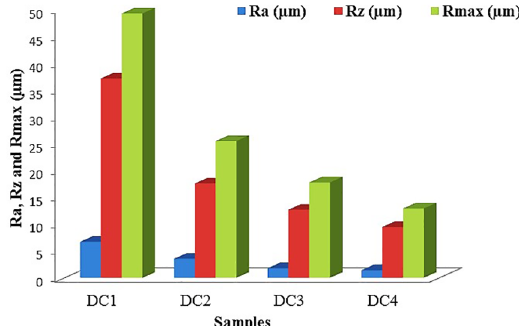
, the maximum Figure 5. Plot of the arithmetic mean deviation R a height R and the highest peak R of the surface roughness. z max the roughness level is high compared to the top of the peak, then the highest peak of R or the maximum height of R max z must be measured 22 .